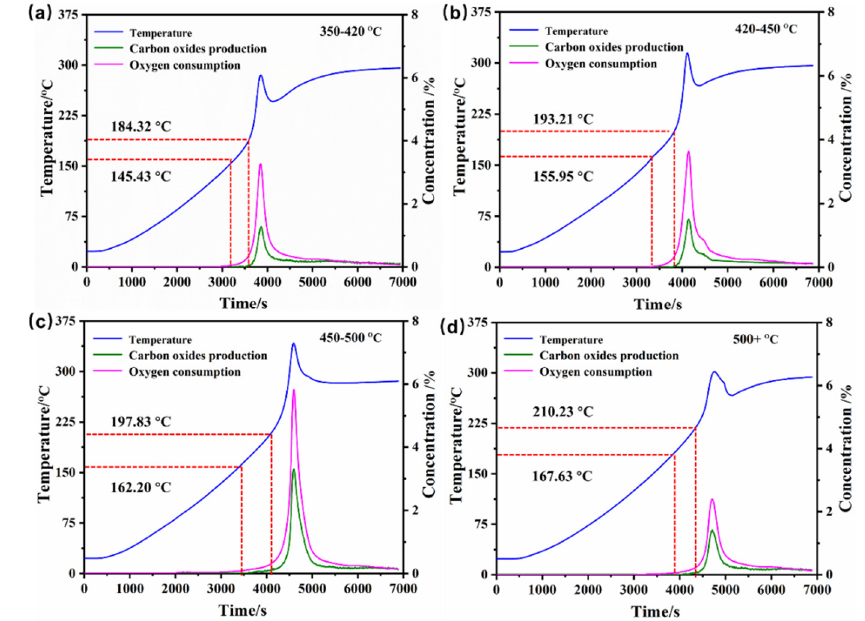
Figure 1. Kinetic cell experiments of different pseudo-components: ( a ) 350–420 °C; ( b ) 420–450 °C; ( c ) 450–500 °C; ( d ) 500+ °C.